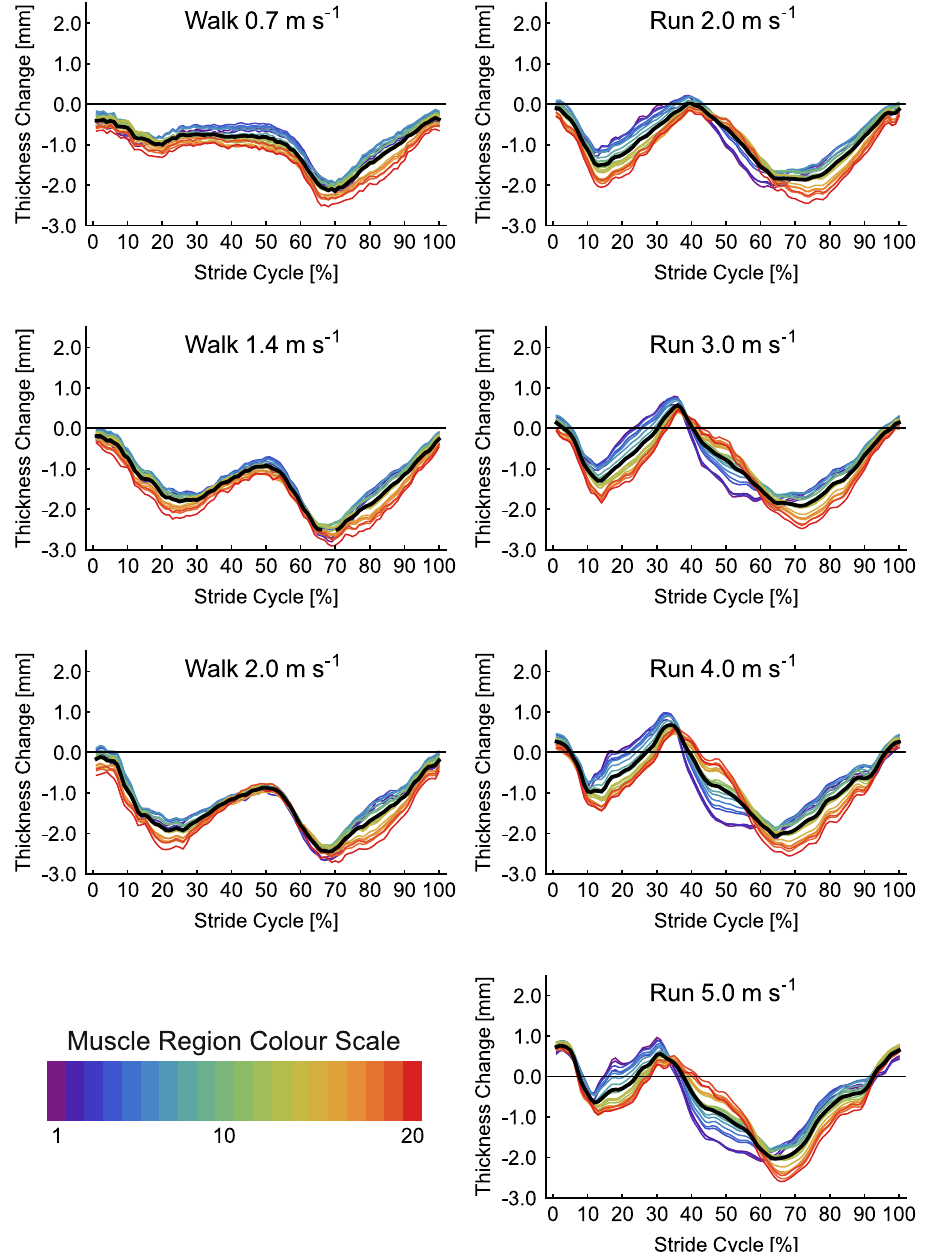
Figure 6. Change in thickness of lateral gastrocnemius muscle a function of stride cycle for each of the seven locomotor conditions studied. Twenty coloured lines represent the change in thickness at each point along the length of the muscle (see colour scale bar and Fig. 1). The thick black line represents the mean